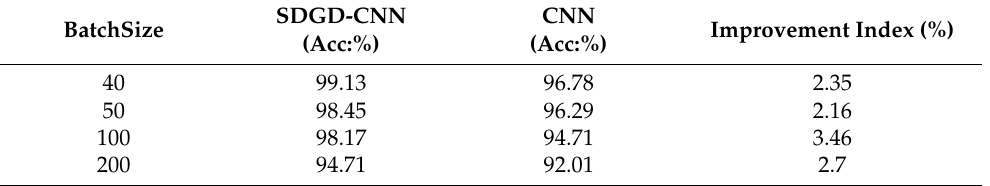
Table 8. Diagnostic accuracy comparison.